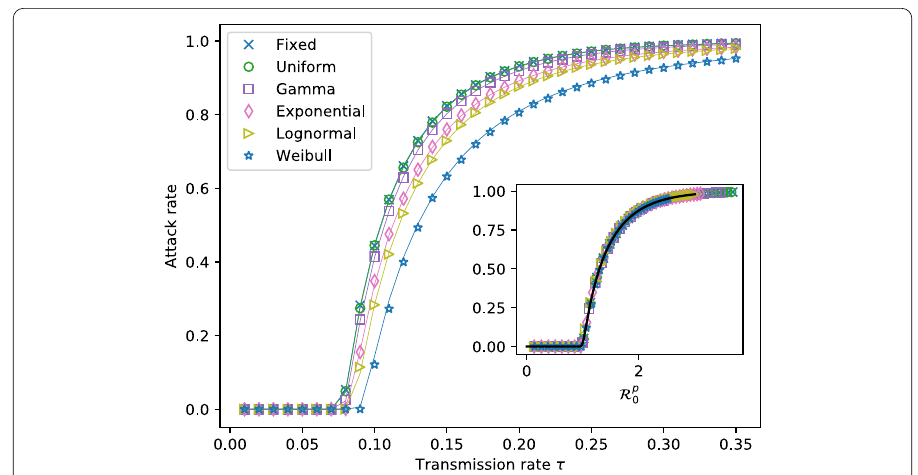
Figure 1 Epidemic sizes in a regular network. We consider the outbreak sizes in a random network with 10 6 nodes all having degree k = 10. We take distributions of infection duration having mean 3/2 and plot the final proportion infected given different transmission rates τ . The inset shows that all final epidemic sizes collapse on a universal curve when using R p 0 as the horizontal axis. The parameters, mean and variance of the distributions are given in Table 1